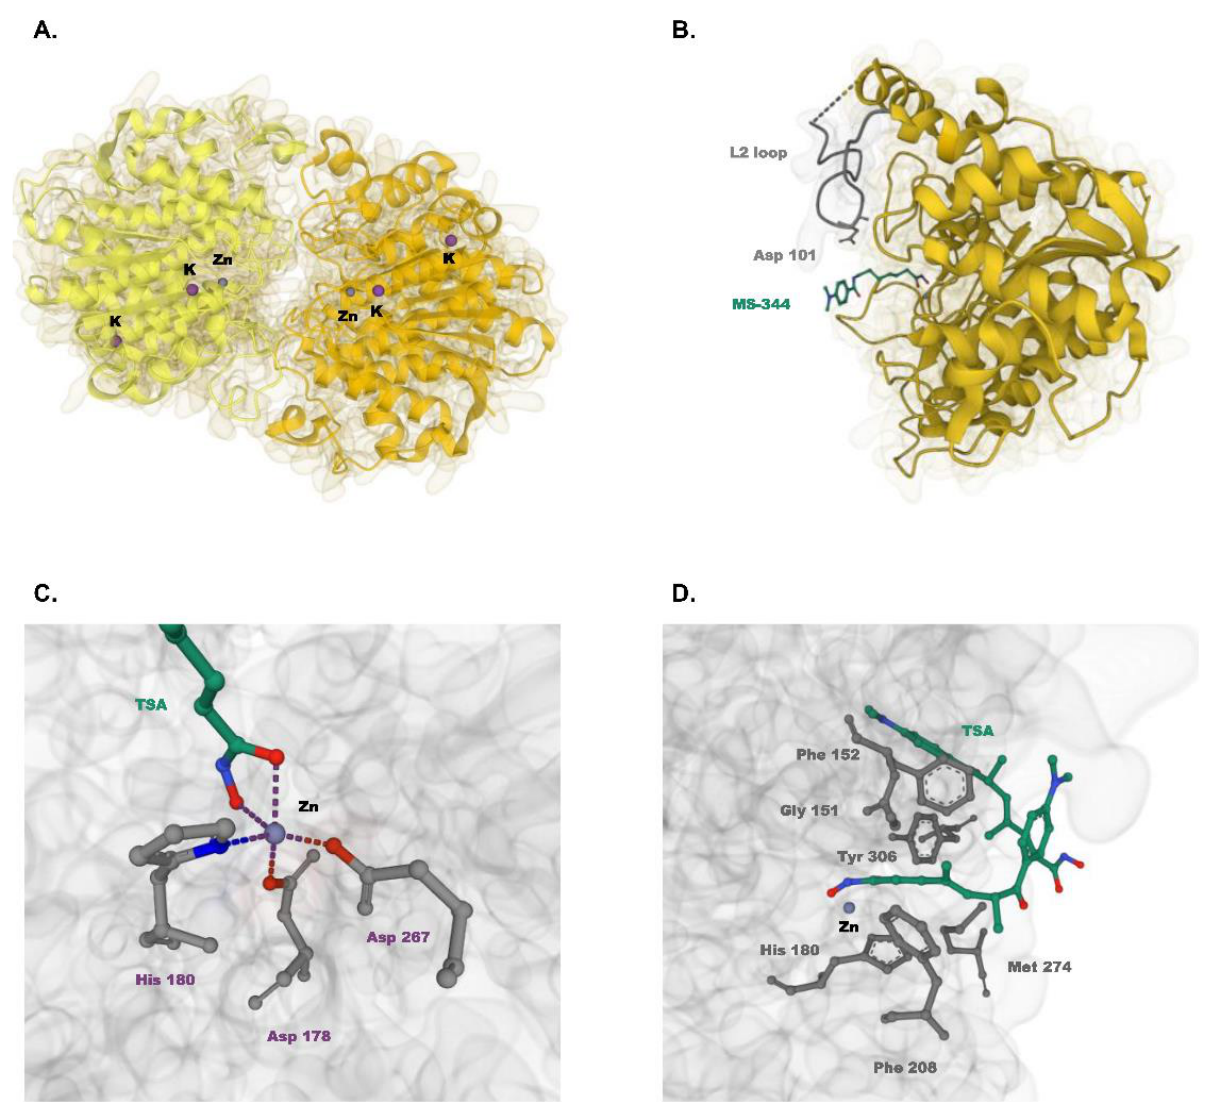
Figure 1. Crystal structure of HDAC8. ( A ) Head-to-head dimeric arrangement of HDAC8 (PDB ID: 2V5W [27]). Two monomers of HDAC8 are shown in light and dark yellow. Zinc and potassium are represented as grey and purple spheres, respectively ( B ) Liganded form of HDAC8 (PDB ID: 1T67 [15]). L2 loop and MS-344 are colored grey and green, respectively. ( C ) Catalytic machinery of HDAC8 (PDB ID: 1T64 [15]). Zinc ion is coordinated to three HDAC8 residues and two oxygen atoms of TSA. The zinc coordination shell is indicated by dashed lines. ( D ) Active site of HDAC8 (PDB ID: 1T64 [15] ). Six key residues form the hydrophobic tunnel that occupies two TSA molecules.